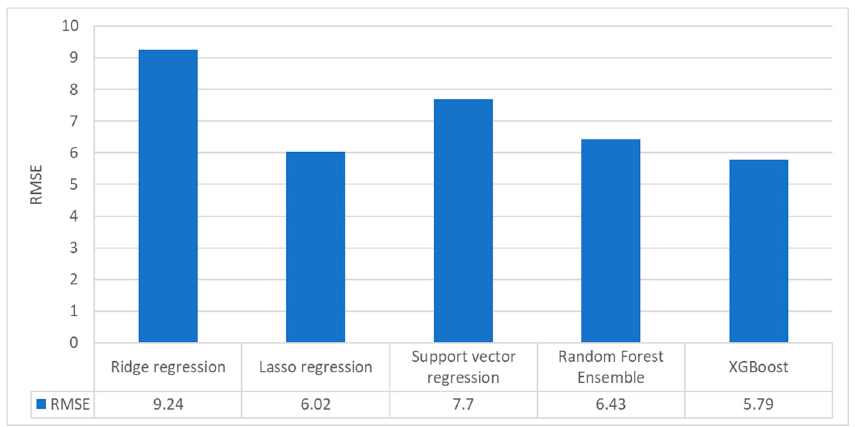
Figure 13. Bar graph representing the TiO 2 estimation performance of the five machine learning algorithms when applied to the test dataset (Dataset II).